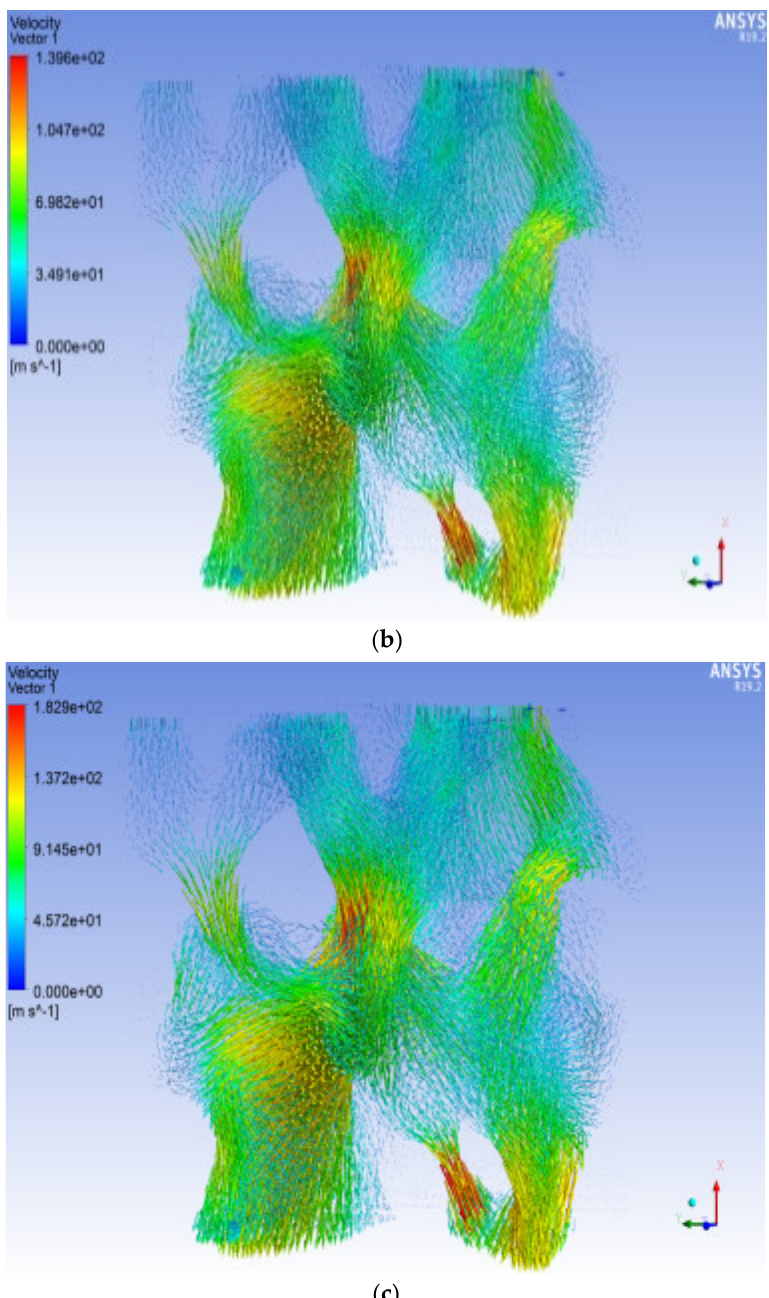
Figure 9. Vector diagram of the seepage velocity distribution at the X direction entrance under different pressures.